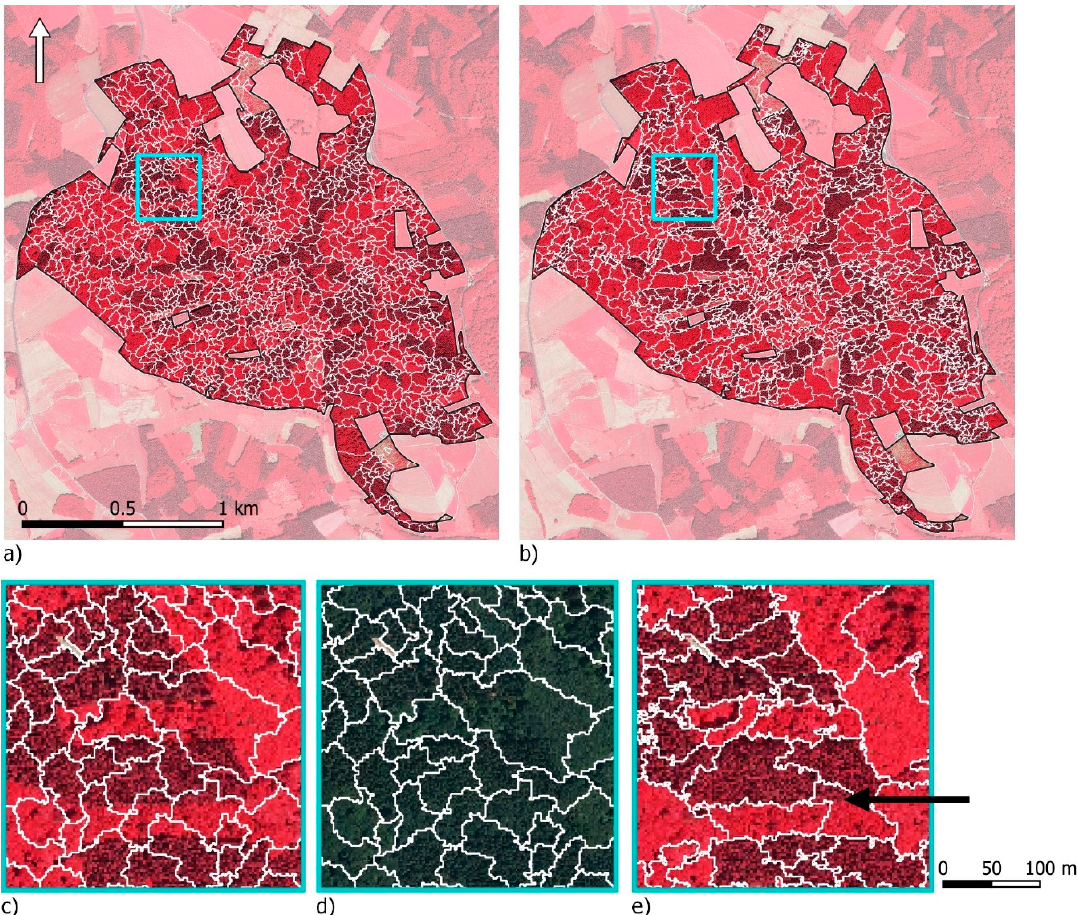
Figure 4. Results of the region growing segmentation on forest area No. 4. based on optimized thresholds ( a ) Overview of the segmentation based on RGB imagery with threshold 0.4; ( b ) Overview of the segmentation based on RGBnIR imagery with threshold 0.46; ( c ) Close-up of segmentation based on RGB imagery; ( d ) Close-up of segmentation on RGB imagery with RGB imagery in the background; ( e ) Close-up of segmentation on RGBnIR.